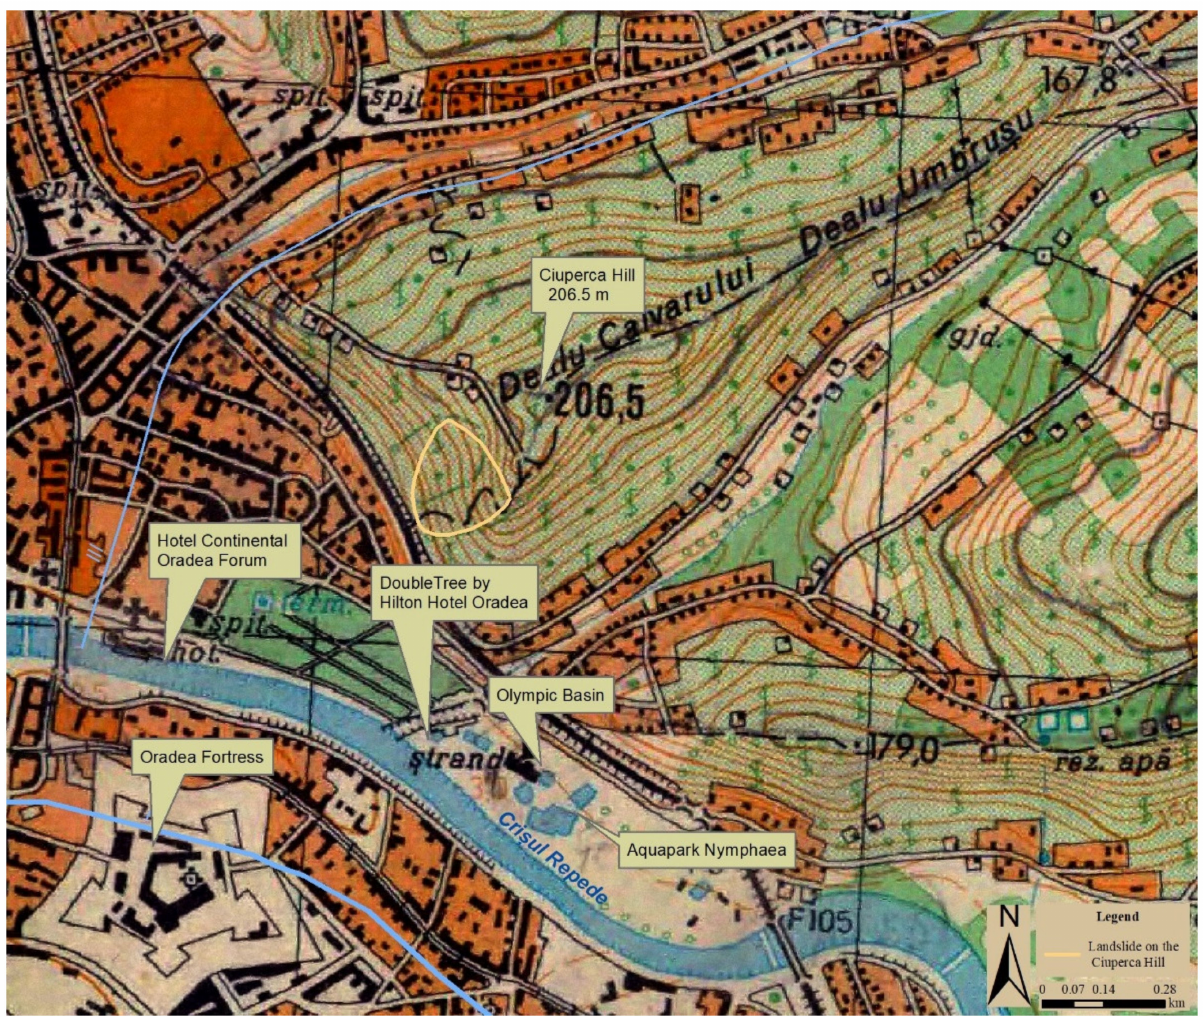
Figure 5. The complementarity of attractions, from the Ciuperca Hill–Oradea Fortress area. Data source: modified after